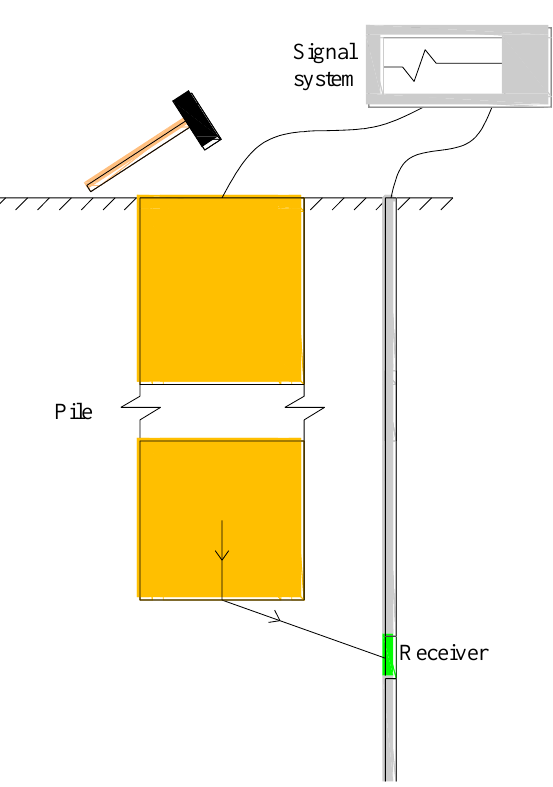
Figure 2. Schematic diagram of the side-hole transmitted wave method.